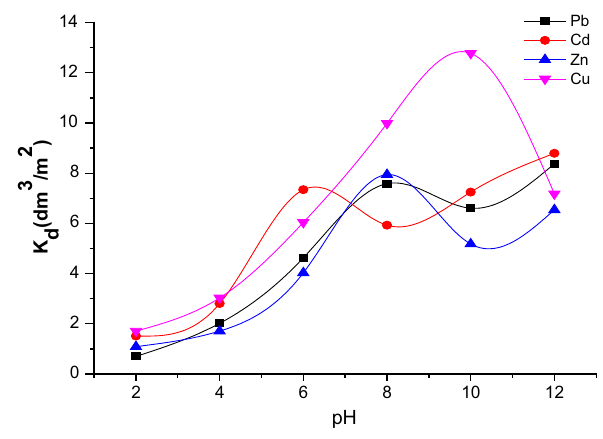
Fig. 6 Sorption edge of Pb(II), Cd(II), Zn(II) and Cu(II) onto Albizia lebbeck pod